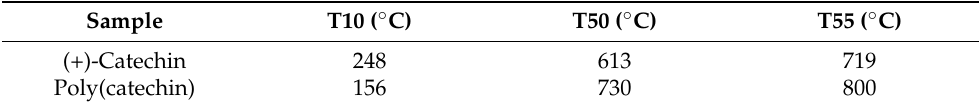
Table 2. T10, T50, and T55 of (+)-catechin and poly(catechin). Standard deviation: temperature ± 0.7 ◦